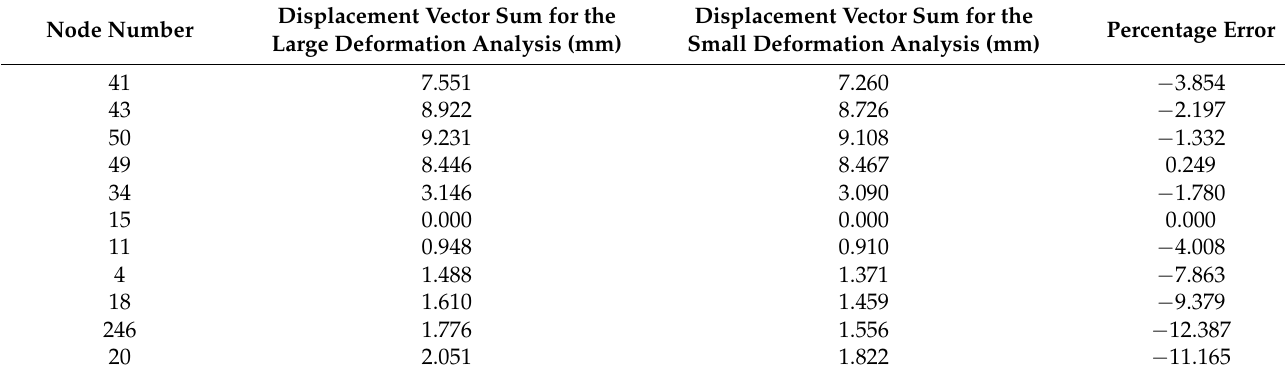
Table 3. Percentage Errors for Problem